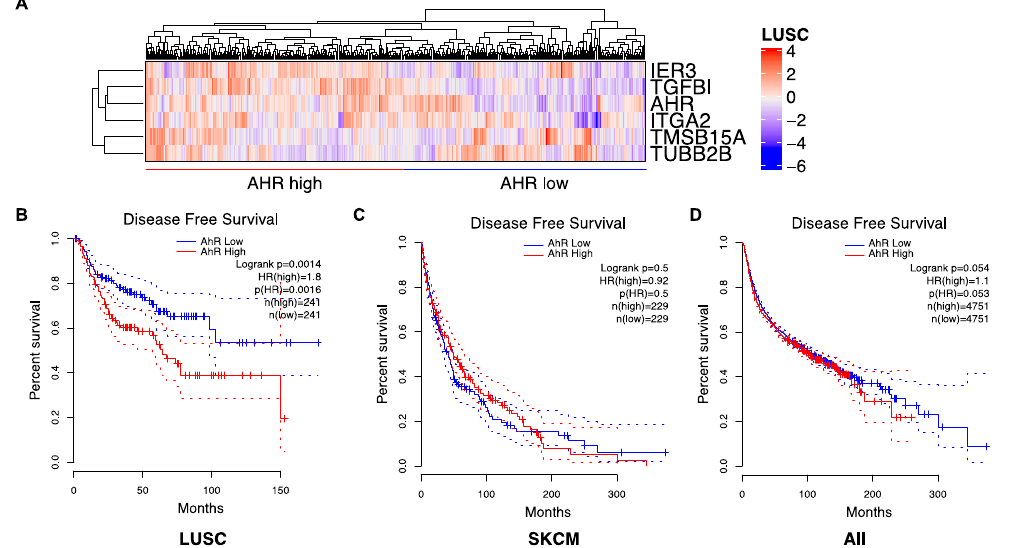
Figure 3. AhR correlated gene signature in LUSC. ( A ) Expression heatmap showing the expression of several AhR-correlated genes in patients with squamous-cell lung cancer ( n = 486). Genes and clusters with similar expression profiles across the cohort are placed close to each other in the grid. ( B – D ) Disease-free survival curves for LUSC cancer patients ( B ), skin cutaneous melanoma (SKCM) patients ( C ), and all cancer patients from the TCGA ( D ), depending on the AhR signature corresponding to genes previously identified as the most positively and negatively ( n = 48) correlated in lung-cancer cell lines.